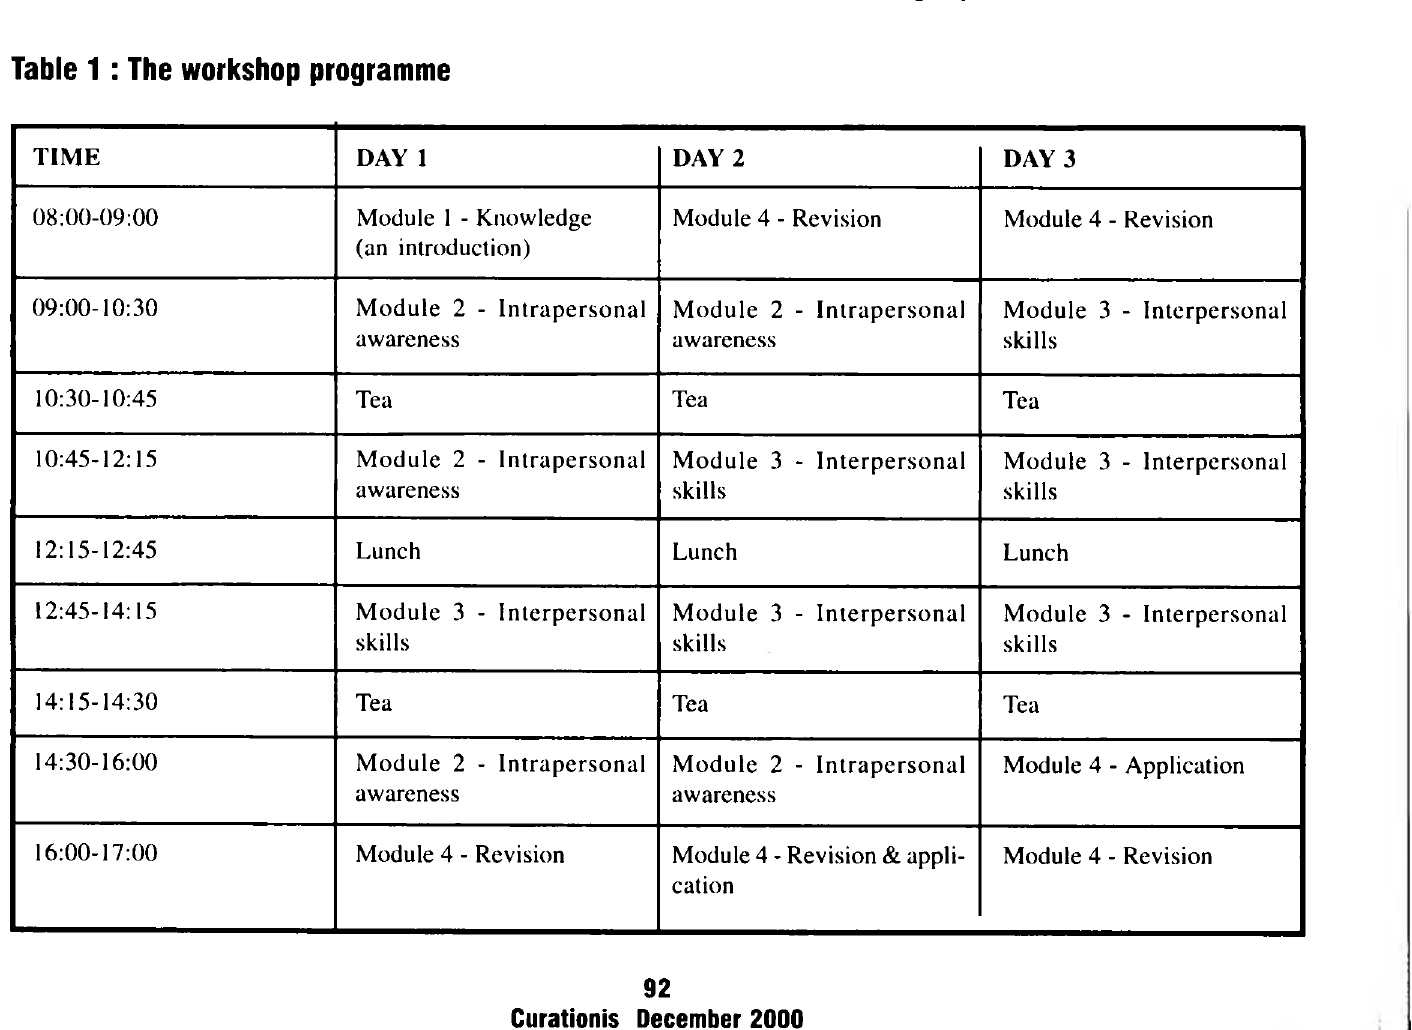
Table 1 : The workshop programme TIM